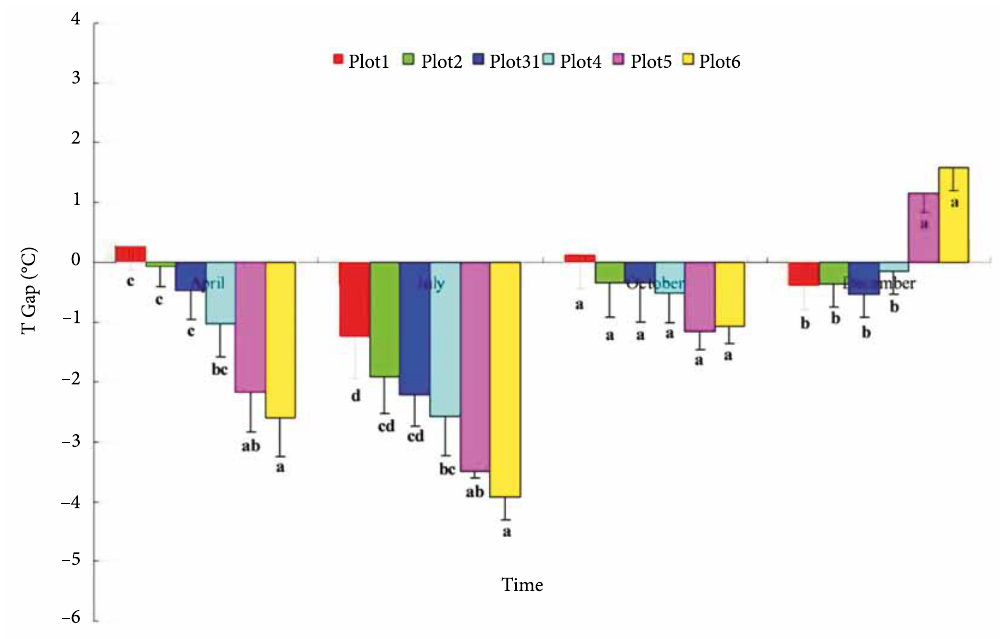
Fig. 5. The 3-day average of air T in the green belts